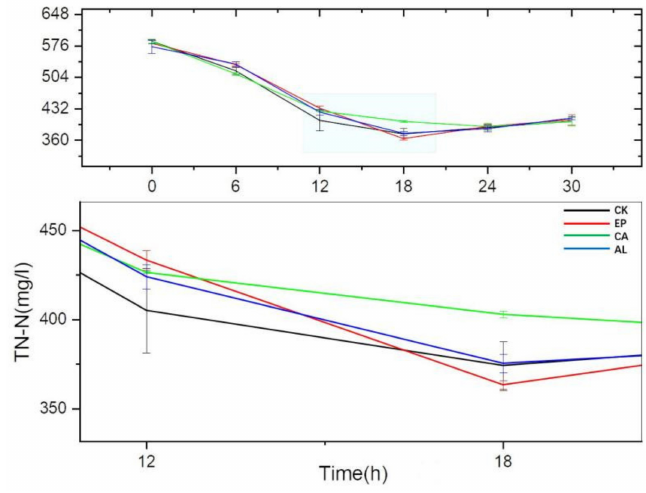
Figure 7. The changes of TN-N concentration with culture